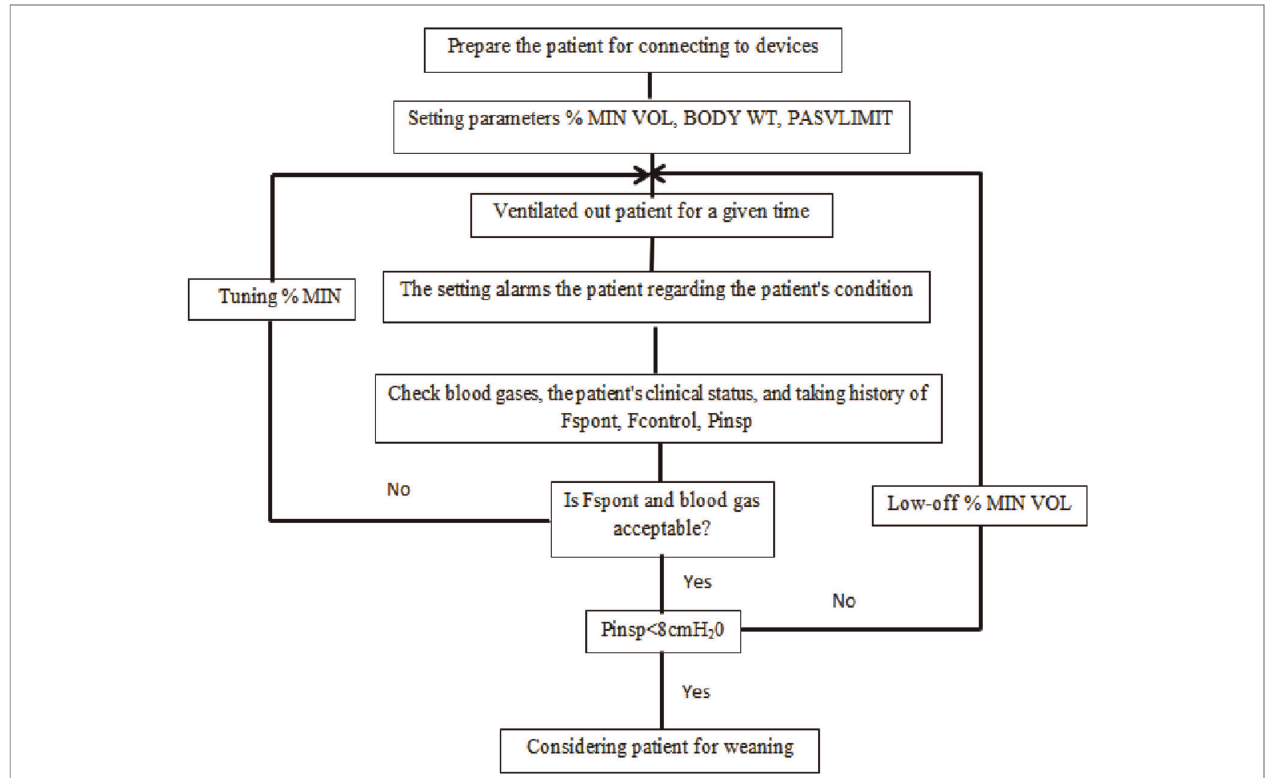
FIGURE 1 | Standard weaning process algorithm in adaptive support ventilation (ASV) mode. MIN VOL, minute volume; WT, weight; F spont, frequency of spontaneous breathing; F control, frequency of controlled breathing; P insp, inspiratory